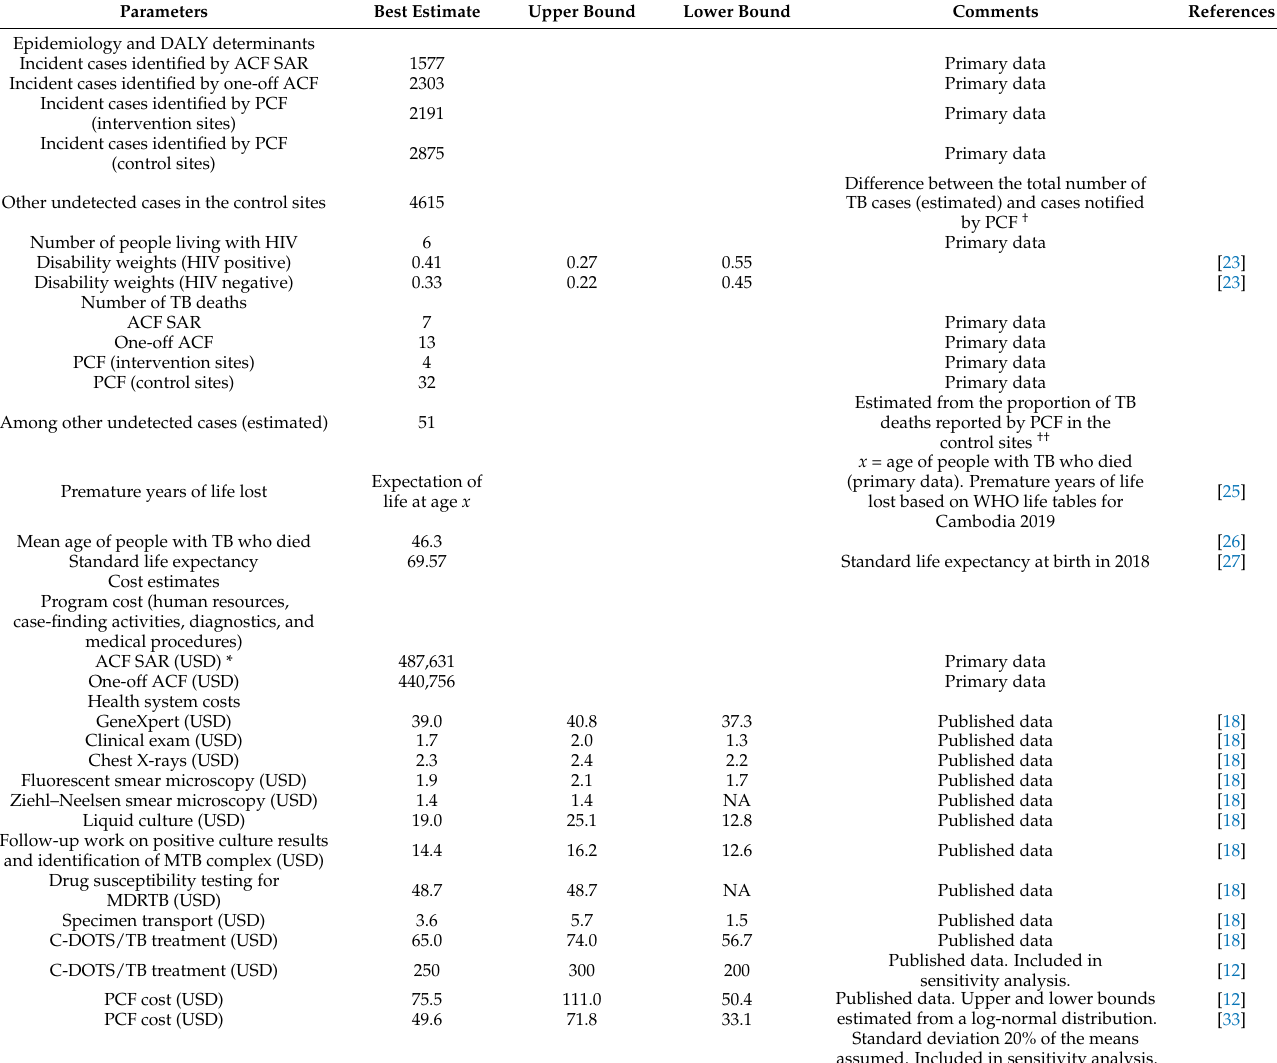
Table 1. Key parameters in cost-effectiveness analysis.